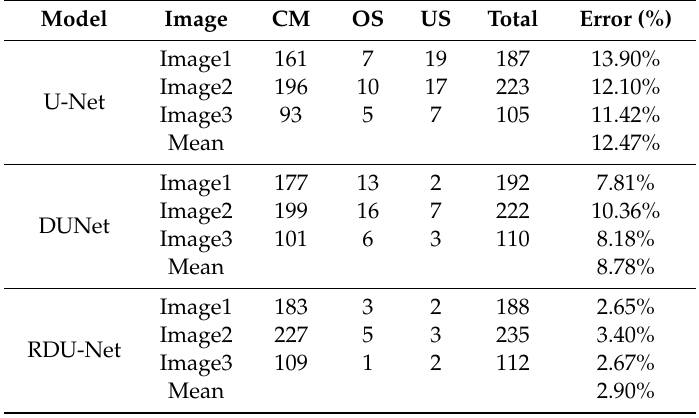
Table 4. Comparison of contour extraction results of test images.